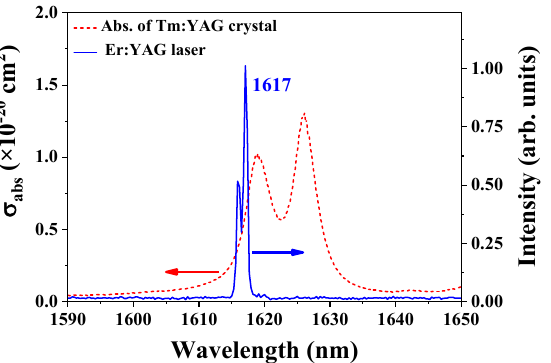
Figure 1. Absorption of the Tm:YAG crystal, including spectral curve of the Er:YAG laser. Figure 2 shows the schematic of the intra ‐ cavity Tm:YAG ‐ Ho:GdVO 4 laser we built.